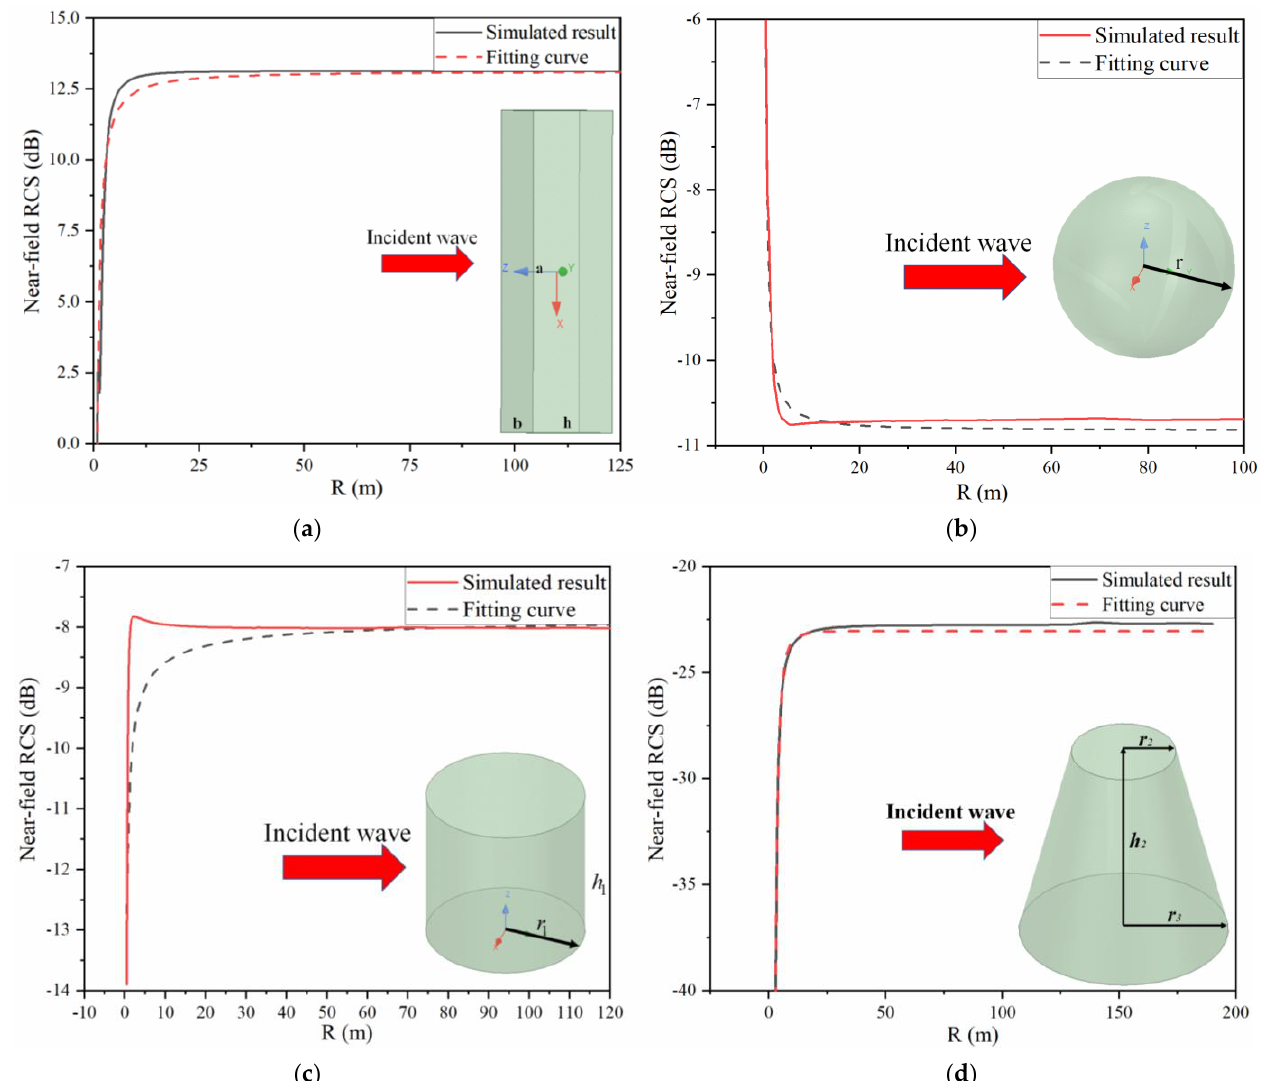
Figure 2. Numerical simulated results and fitting curves of the near-field radar cross section for different targets. ( a ) Plate; ( b ) sphere; ( c ) cylinder; ( d ) conical frustum.